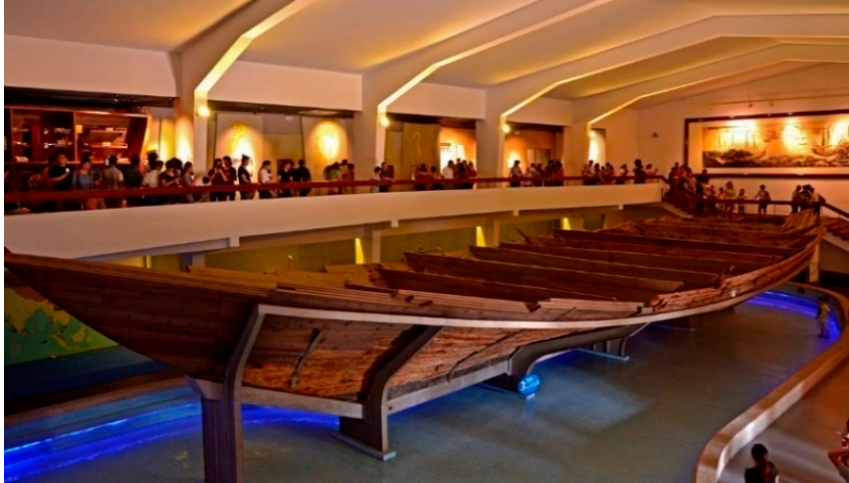
Figure 7. The Song Dynasty shipwreck in Quanzhou Bay [53].